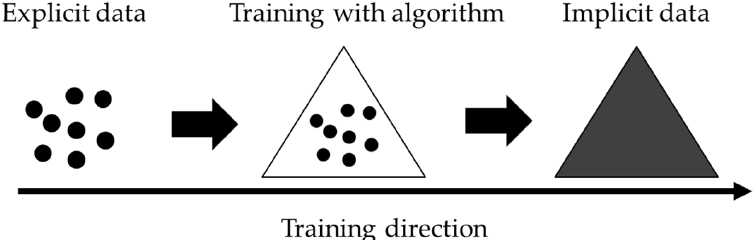
Figure 6. Explicit and Implicit data. Implicit data are embedded in the algorithms, and explicit data are separated from the